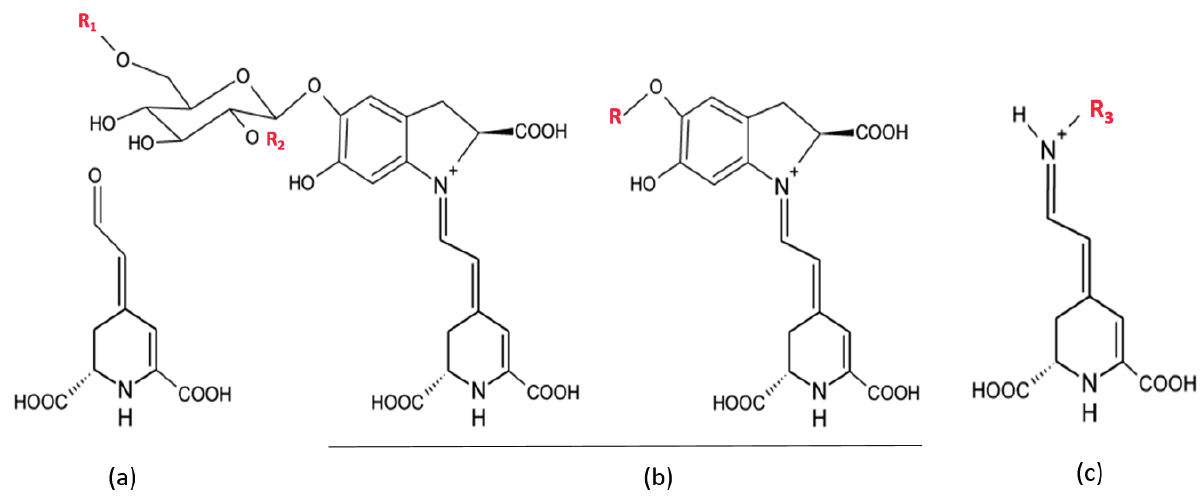
Figure 1. General structure of betalamic acid ( a ), betacyanins ( b ) and betaxanthins ( c )